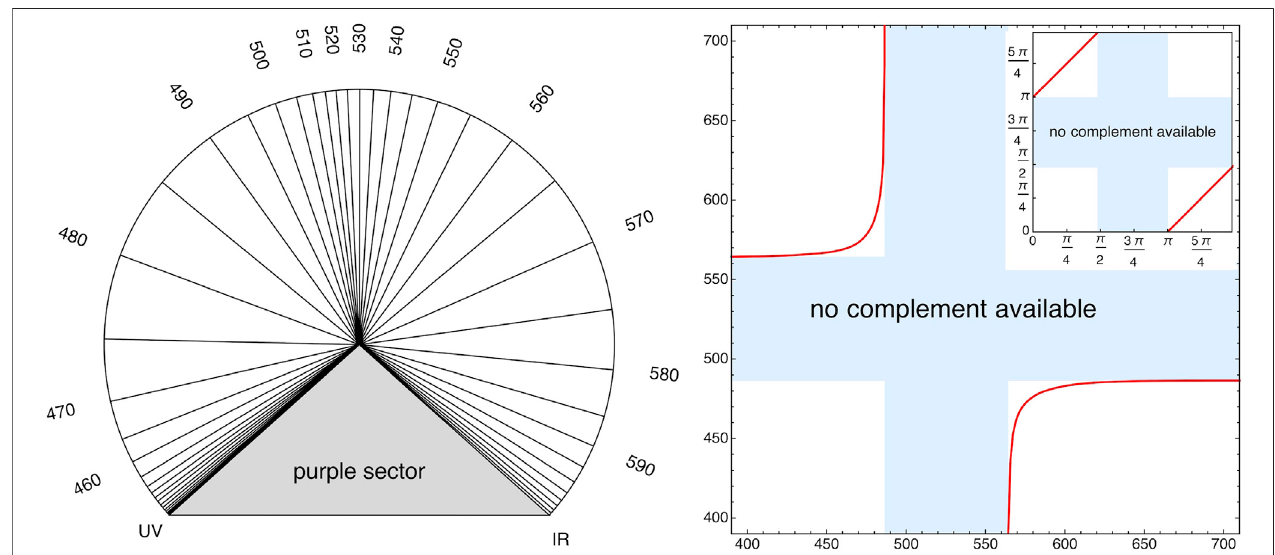
FIGURE2|Left :Thisviewisinthe RGB – space( Section4.3 ),whichhasaEuclidianmetric.Itisanorthographicviewofthespectrumconefromthedirectionofthe achromatic direction. In this geometry angles in the plane orthogonal to the achromatic direction are meaningful. The parameterization by angle is then preferable over parameterization by wavelength. The latter is essentially arbitrary. Right : Complementary wavelengths are de fi ned by spectrum generators that are coplanar with the achromatic direction W . In the angular parameterization (in this fi gure and Section 4.3 ) they are an angle π apart (the inset). Note that not every wavelength has a complementary